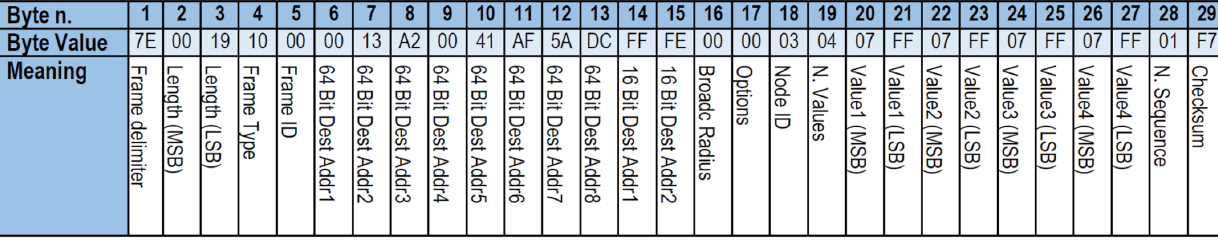
Figure 4. Frame used by the microcontroller at the Smart Measuring Nodes to send the values acquired from the sensors.